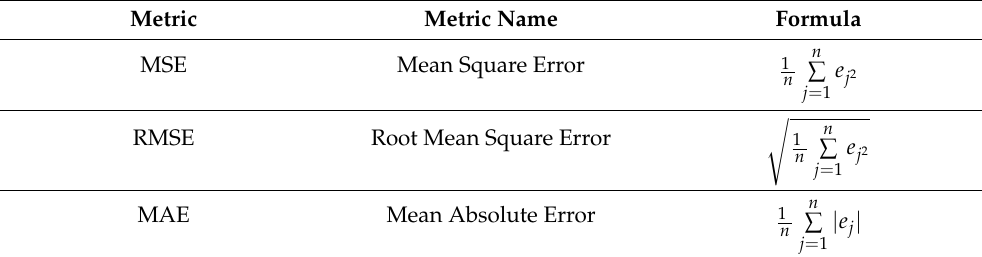
Table 2. Performance